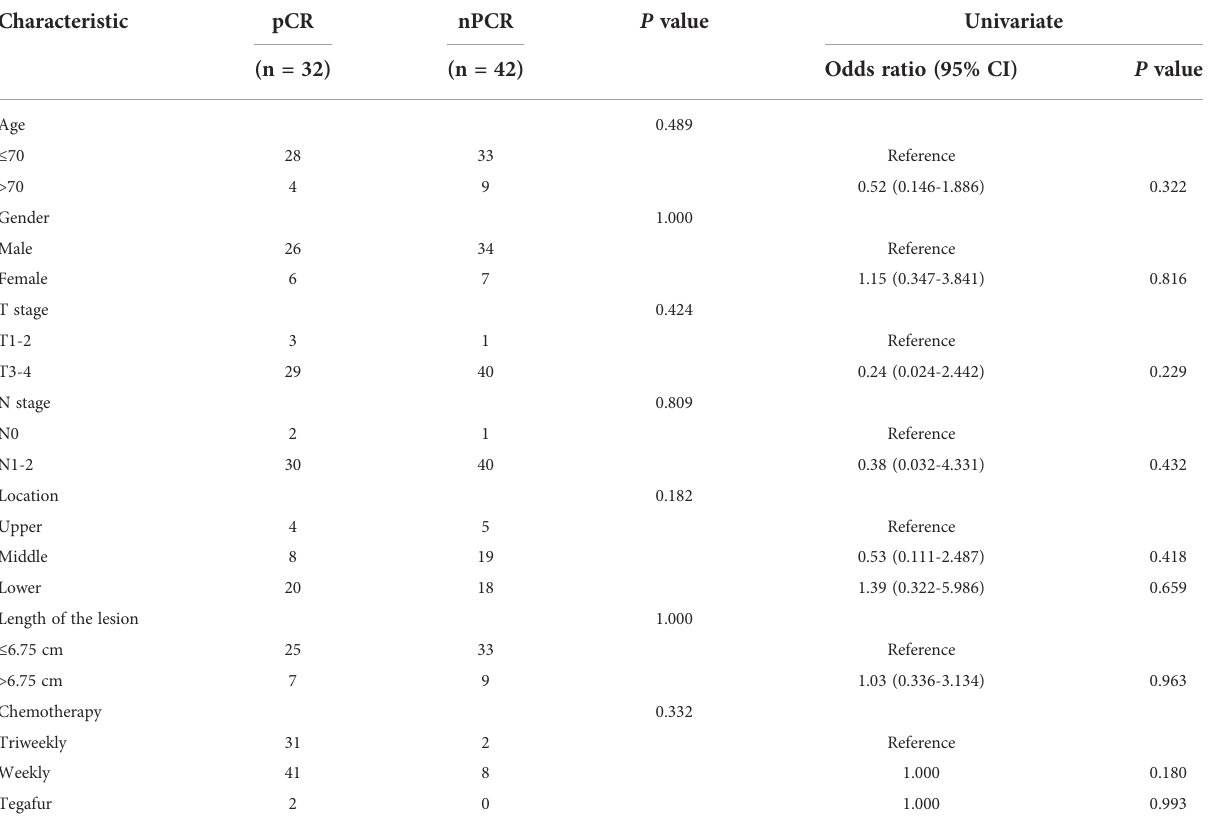
TABLE 2 Patient characteristics between pCR and npCR